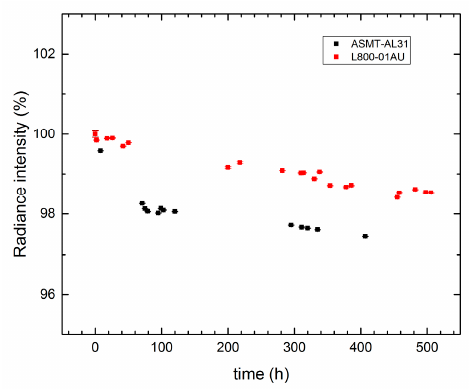
Figure 7. Radiance intensity as a function of the operating time in hours of the LED sources normalized to the initial value.